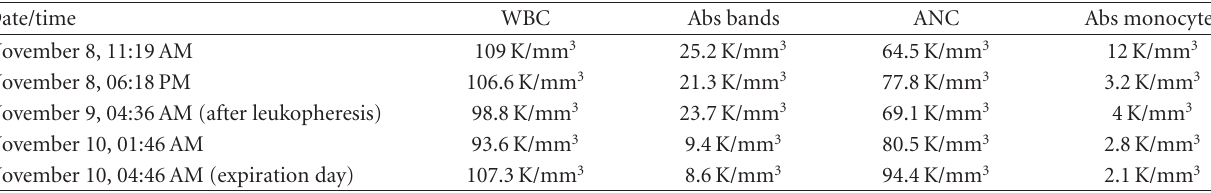
Table 1: Display of the remarkable laboratory values during patient’s hospitalization.